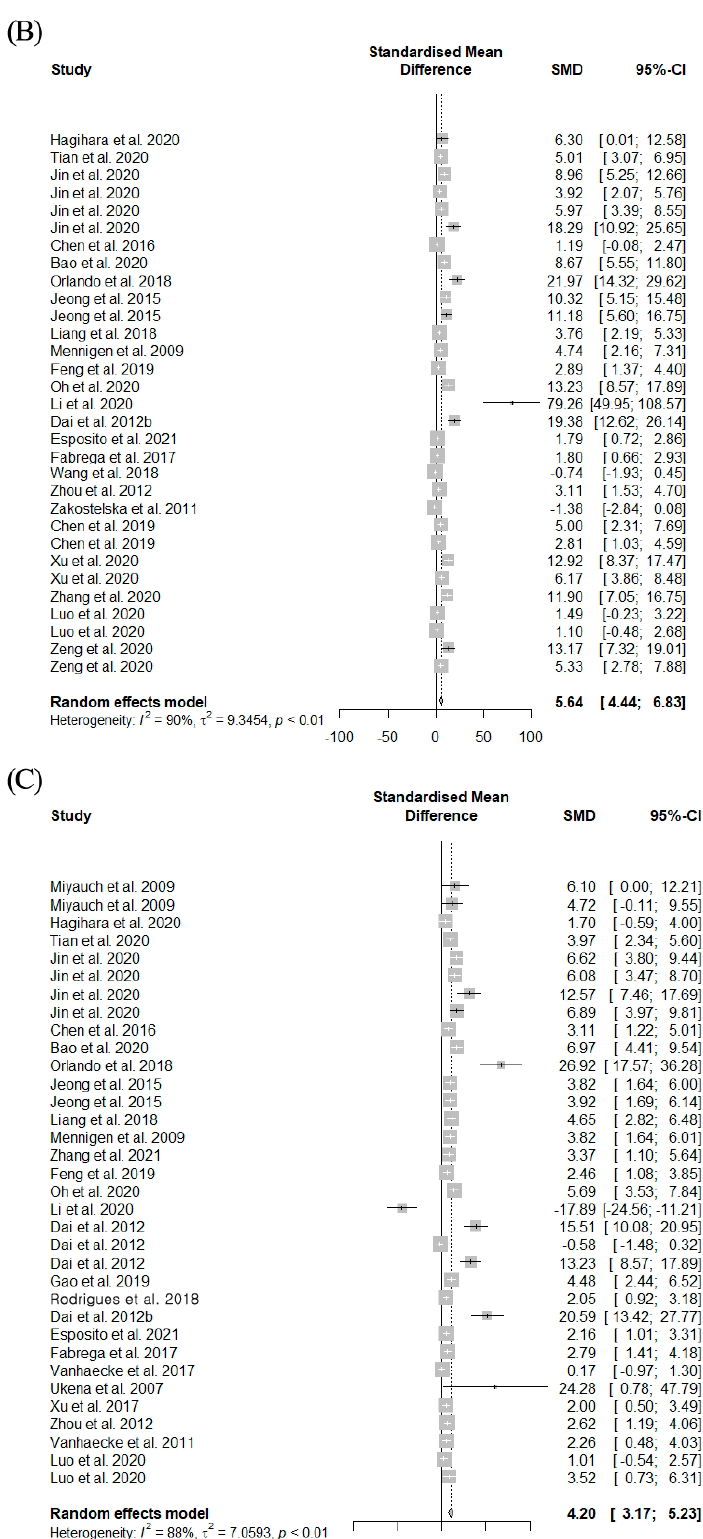
Figure 2. Forest plot for effect size of probiotics administration on tight junction protein expression by random effect model. ( A ) claudin; ( B ) occludin; ( C ) ZO − 1, [24–28,30,32,37,38,40–43,45–47,50,51,57,59,61–69]. Figure 3 denotes the effect size on mRNA expression of TJP. All analyzed items, including claudin, occludin, and ZO-1, showed a positive effect model. There were significance